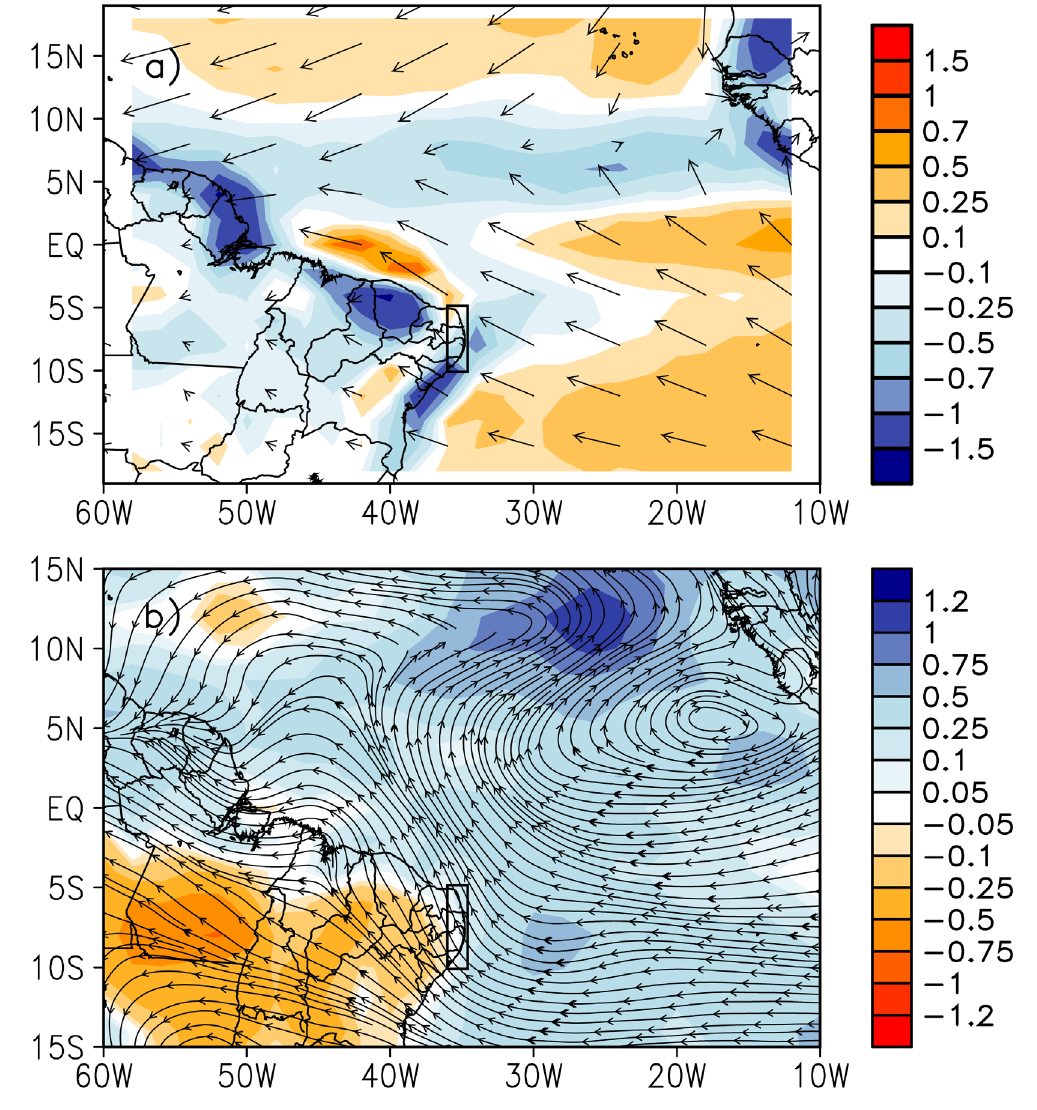
Figure 4. a Average anomalous vertically integrated water vapor transport (1000-300 hPa) (vectors, kg m -1 s -1 ) and its divergence (colors, 10 -5 x kg m -2 s -1 ); b Specific moisture (colors, g kg-¹) and anomalous circulation current lines at 850 hPa during May the July in the period from 2012 to 2017. The anomalies were calculated based on the climatological average for